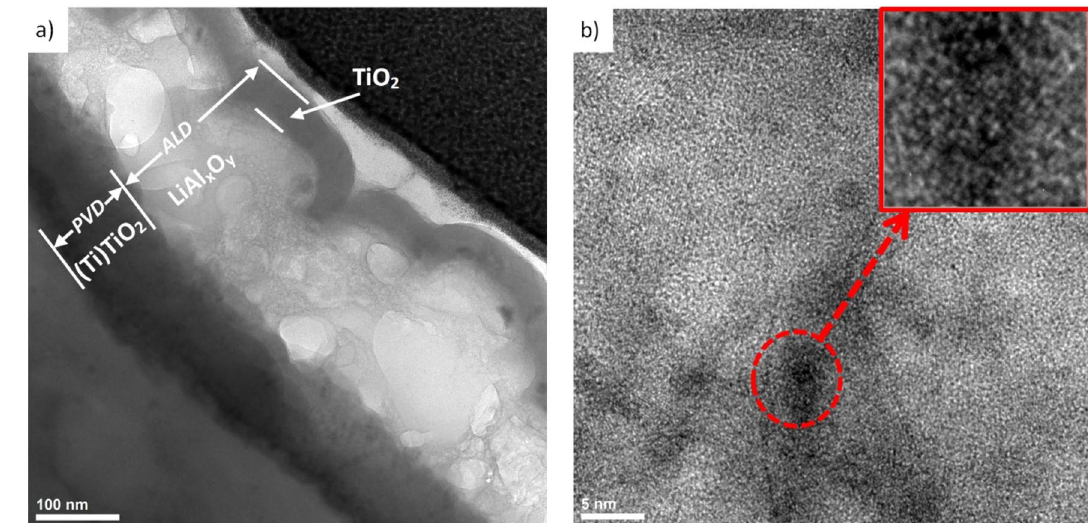
Figure 6. Structure (HR-TEM) of Ti + TiO 2 /Al 2 O 3 + TiO 2 hybrid coating on LAE 442 alloy substrate: ( a ) the entire cross-section of the coating, ( b ) Al 2 O 3 (LiAl x O y ) ALD layer.